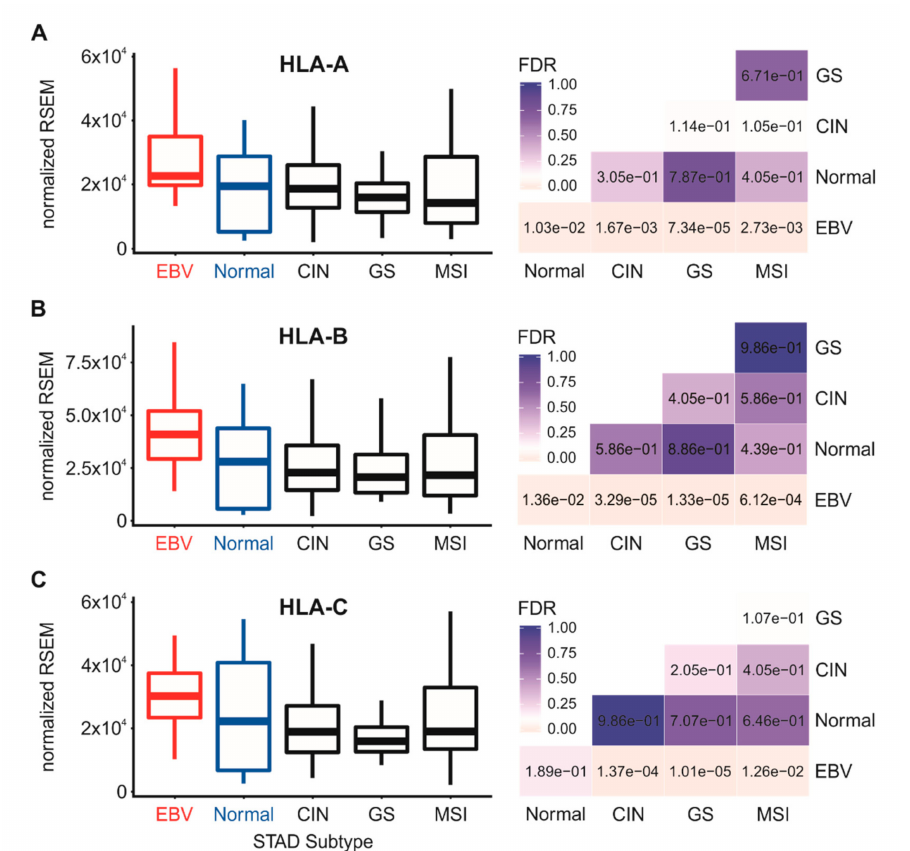
Figure 1. Expression of classical MHC-I heavy chain gene mRNA in gastric carcinoma subtypes